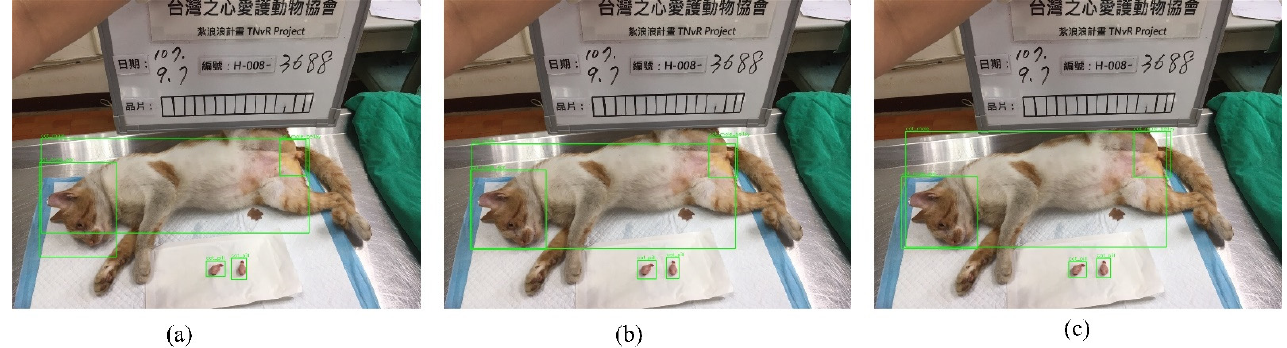
Figure 9. Pictures of the Yolov3-Tiny ( a ), Yolov3 ( b ) and Yolov4 ′ s ( c ) detection performance for Male Cat. Table 6. Detection performance for male cat.